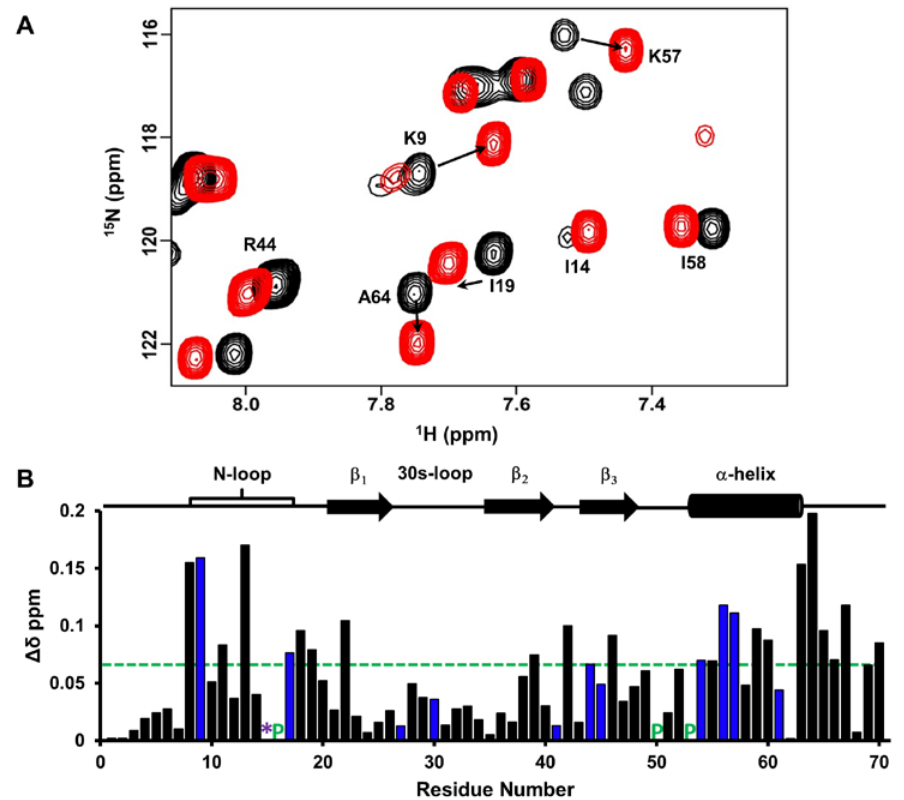
Figure 6. CXCL7 monomer binding to heparin dp8. ( A ) Portion of the HSQC spectrum showing the overlay of CXCL7 in the free (black) and in the presence of heparin dp8 at a 1:4 molar ratio (red). Residues that show significant perturbation are labeled; ( B ) Histogram plot of binding-induced chemical shift changes in CXCL7 monomer as a function of amino acid sequence. Residues that show CSP above the threshold (dashed line) are considered perturbed. Basic residues Arg, Lys and His are shown in blue. Residue H15 is broadened out in the free spectra and is represented by a “*”. Prolines are shown by a green “P”. Secondary structural elements are given for reference.